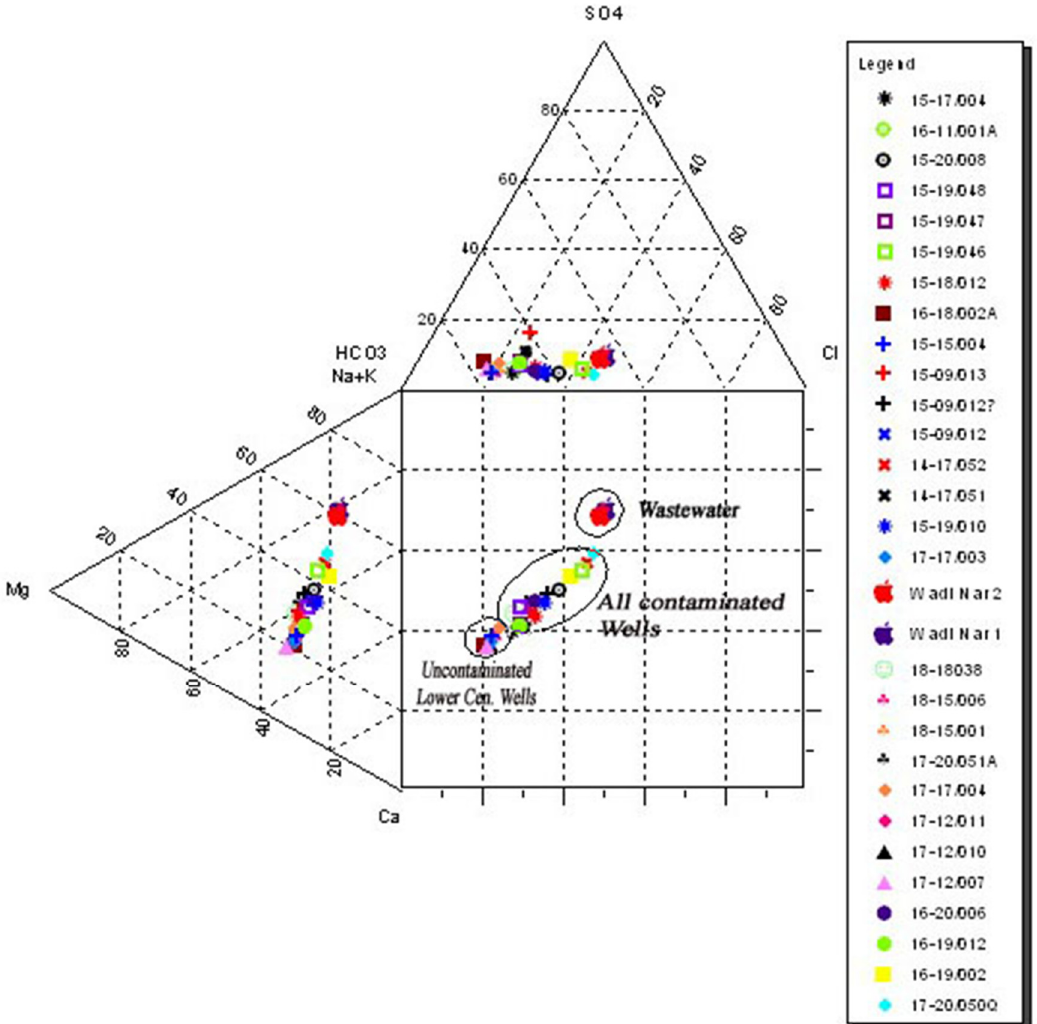
Figure 4. Durov diagram for domestic wells included in the study, tapping the mountain aquifer in the West Bank, and wastewater (Legend stands for a well ID) .